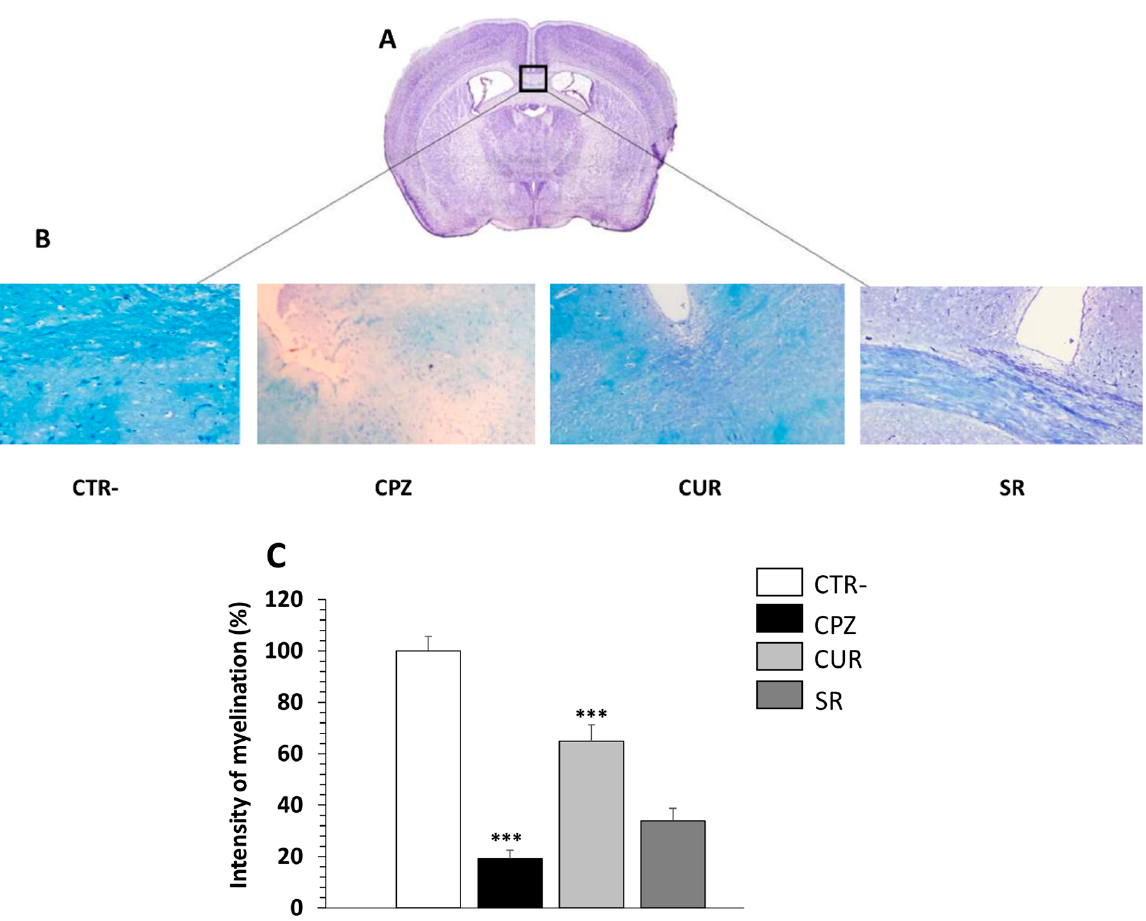
Figure 7. Effect of curcumin treatment on demyelination induced by cuprizone intake in the corpus callosum of mice. ( A ) Adapted from Paxinos Franklin Mouse Brain Atlas. ( B ) Representative images for LFB staining results (Obj × 20). ( C ) Evaluation of myelination index by analyzing LFB intensity. n = 10 brain sections from three mice, per experimental group. Negative group (CTR-), cuprizone- mice (CPZ) group, post-treated with curcumin (CUR) group and spontaneous remyelination mice (SR). Values are given as mean ± SEM, as the results of ordinary one-way ANOVA followed by Tukey’s multiple comparison test; *** p < 0.001.